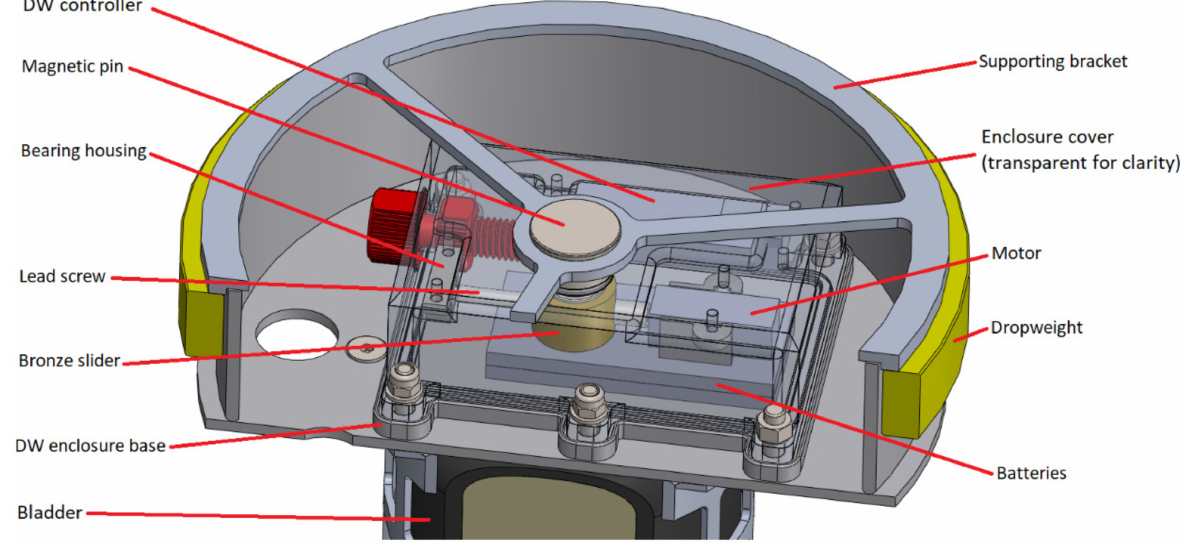
Figure 3. Drop-weight mechanism (upside down for